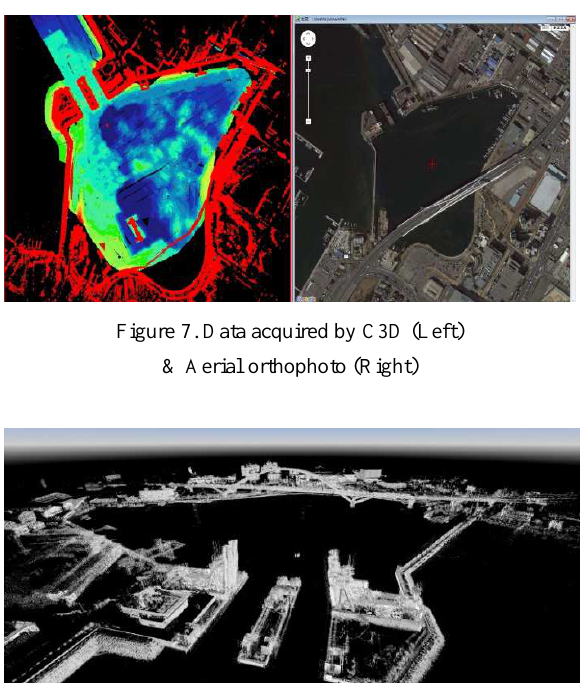
Figure 6. Point cloud of LMV and Omnidirectional image link function 4. RESULT OF VERIFICATION TESTS C3D can acquire detailed seabed topography. Figure 7. shows bathymetry of gradient tints where point cloud of surrounding land is shown in red (left) to compare with aerial ortho photo (right).